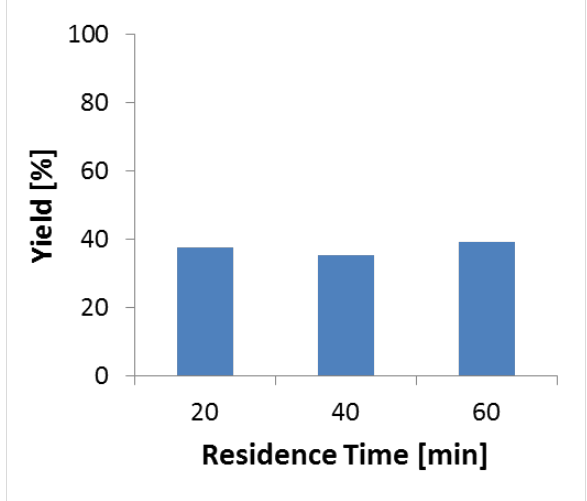
Figure 3: Batch reaction using free enzyme. Reaction conditions: Reaction volume (10 mL), TA (2.7 mg, specific activity – 0.135 U/mg), temperature (70 °C).